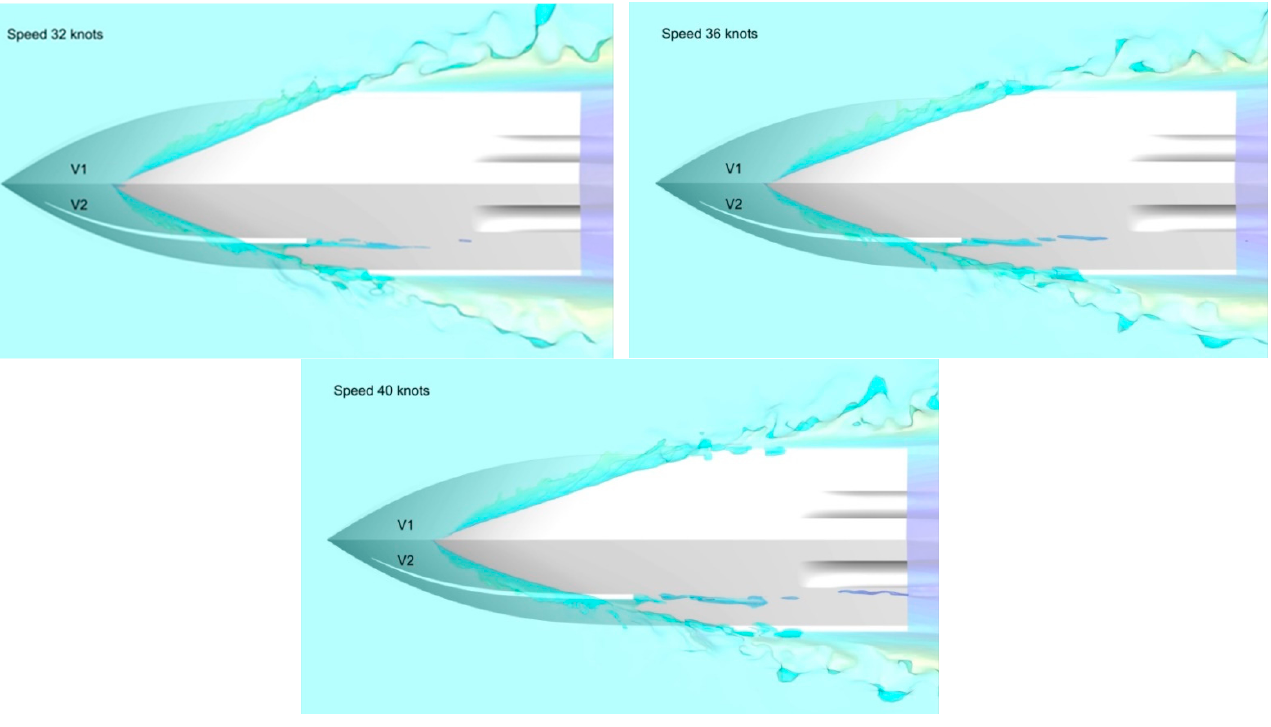
Figure 15. Comparison of free-surface and air-pocket development for V1 and V2, at 32, 36 and 40 kn.